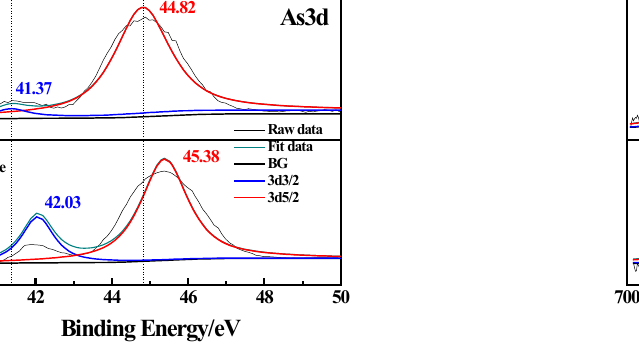
Figure 8. The ( a ) As 3d and ( b ) Fe 2p spectrum before and after interaction with